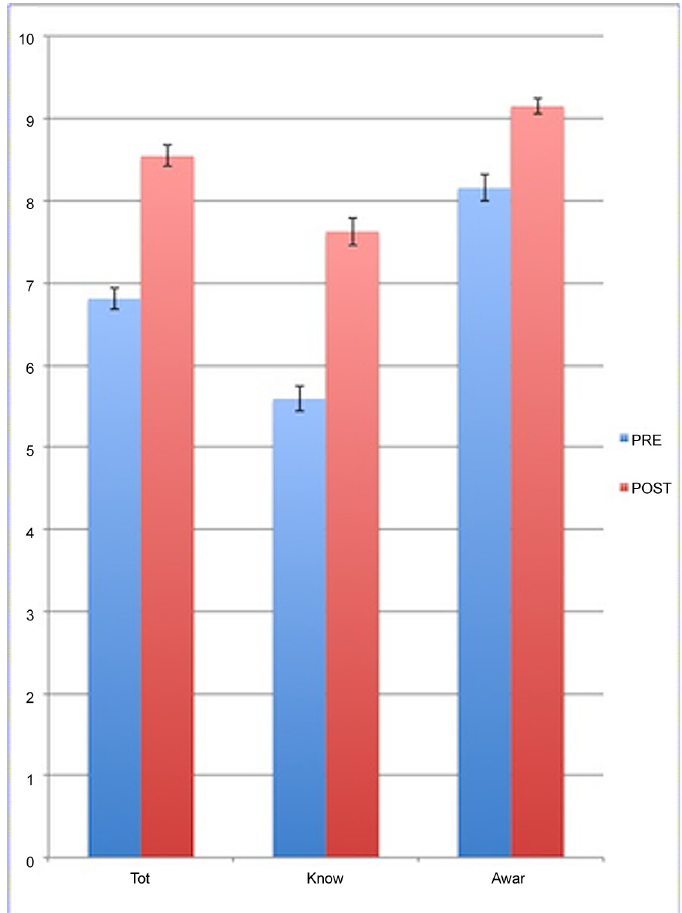
Fig 2. Mean score of the environmental education evaluation questionnaire. Tot represents the mean score of the overall questionnaires, Know represents the mean score of the reef biology questions and Awar represents the mean score of the human impact questions. Error bars are 95% confidence intervals (CI), N = 212.